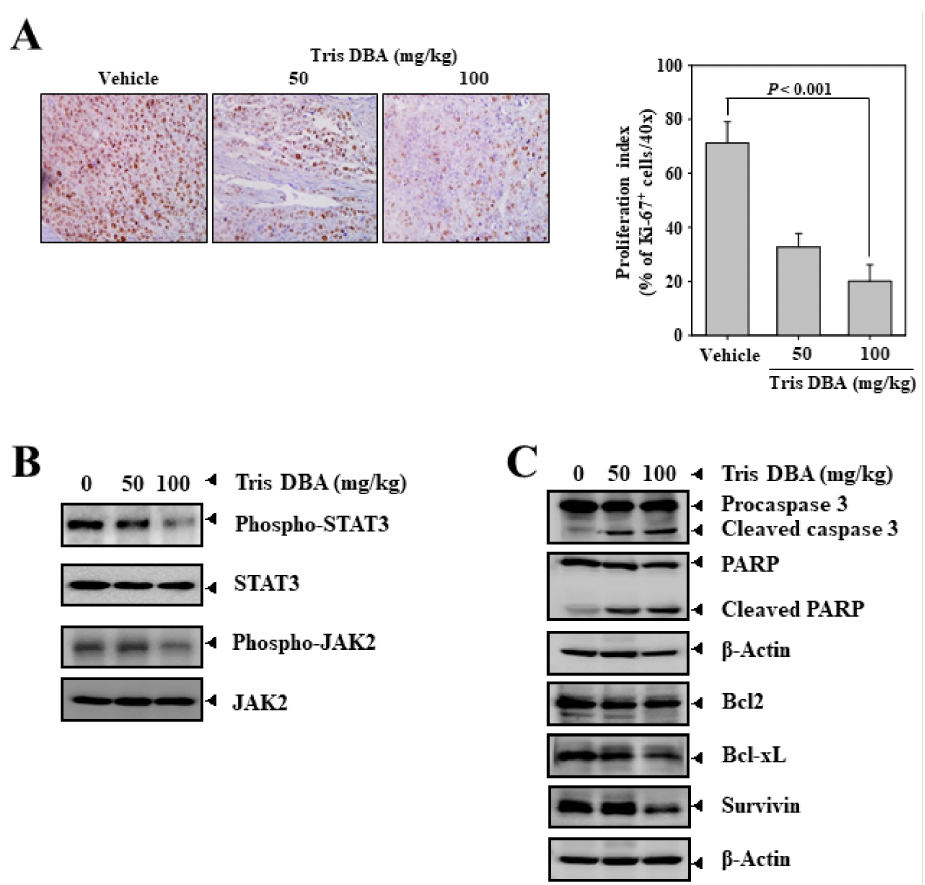
Figure 8. Tris DBA decreases the activation of STAT3 and its regulatory proteins as well as the levels of its downstream proteins. ( A ) MM tumor tissue from Tris-DBA treated and the untreated group was used for examination of the expression of Ki-67 by immunohistochemistry analysis. ( B , C ) The expression of STAT3 signaling pathway proteins and apoptotic markers was examined in MM tumor